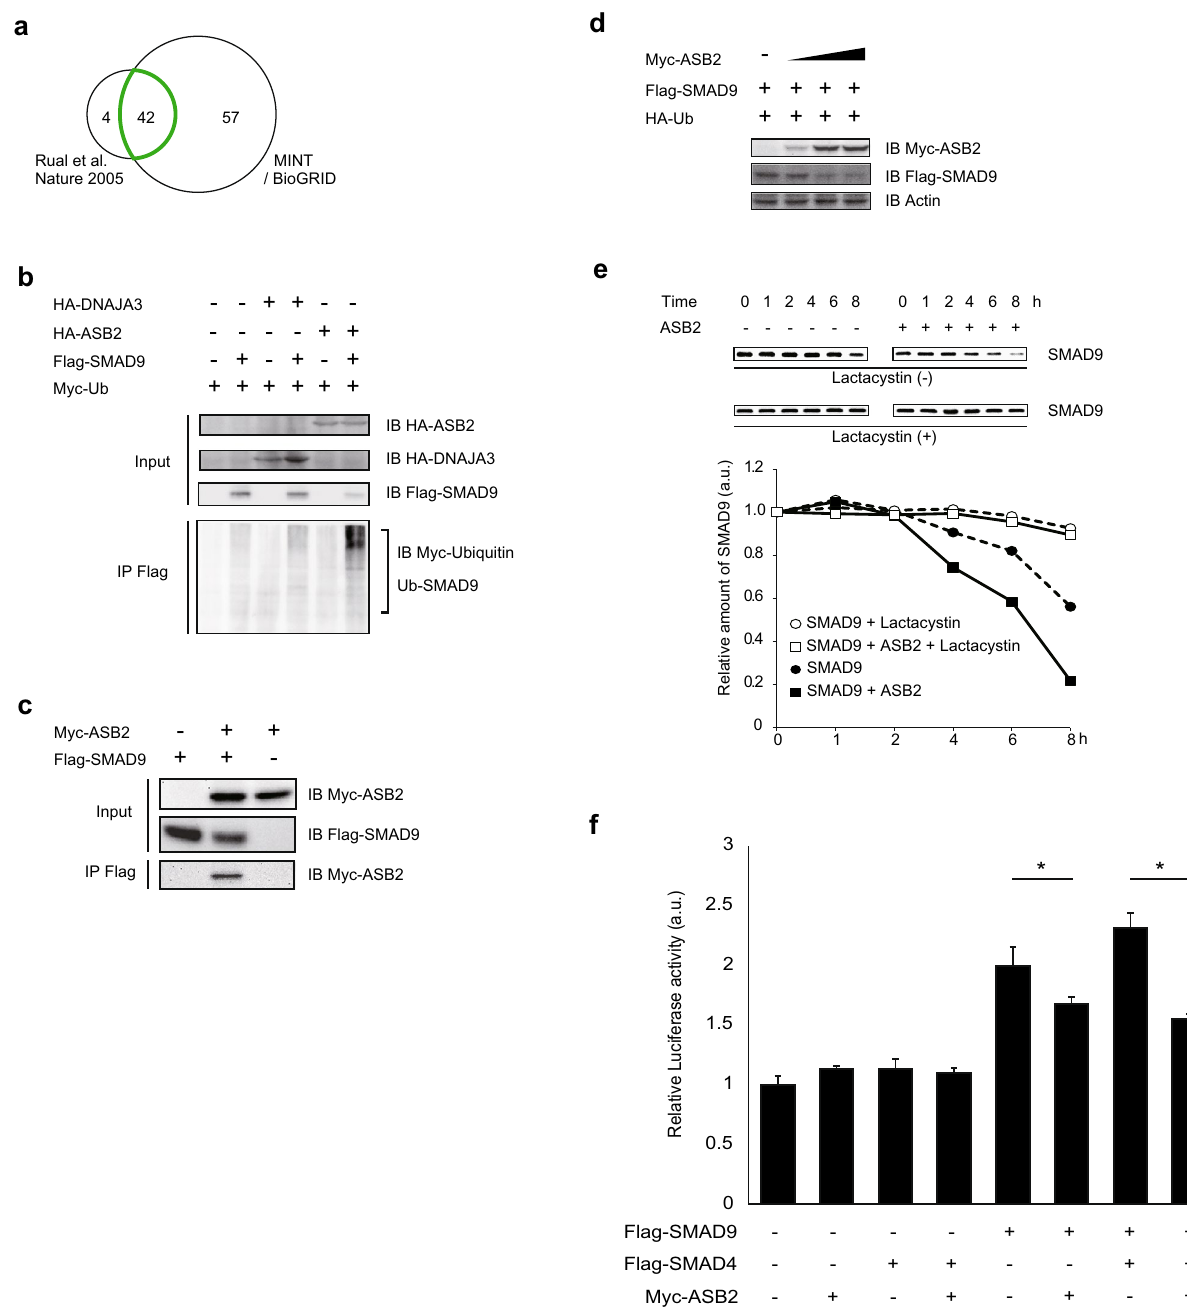
Figure 1. ASB2 is a novel E3 ligase of SMAD9. ( a ) Independent databeses of interactome were used to narrow the candidates for SMAD9-binding proteins. Finally, 42 proteins were remained (see Table1). ( b – d ) HEK293T cells were transfected with vectors encoding indicated tagged proteins and Flag-immunoprecipitates or lysates were separated using SDS-PAGE and immunoblotted with the indicated antibodies. ( b ) ASB2 but not DNAJA3 ubiquitilated SMAD. ( c ) ASB2 interacts SMAD9. ( d ) The amounts of transfected vector encoding Myc-Asb2 were 0, 0.1, 1, and 2 µg, respectively (from the left column) The total amount of the transfected vector was adjusted using empty vector. The protein amount of SMAD9 was negatively correlated with that of ASB2. ( e ) Pulse chase analysis. To terminate further protein synthesis, cells were treated with 50 µg/mL cycloheximide with or without 10 µM lactacystin at 24 h after transfection. Total cell lysates were obtained at the indicated times and subjected to western blot analysis. Protein levels were determined using densitometry. ( f ) Asb2 suppress BMP signalling through degradation of Smad9. HeLa cells were co-transfected with Xvent2-Luc plasmid, which expresses luciferase under BMP signalling, and a pGL4.75 vector as a control, which constantly expresses Renilla luciferase, and vectors encoding Flag-SMAD9, Flag-SMAD4 and Myc-ASB2 as indicated. Cells were treated with 100 µM BMP2. Using cell lysates obtained 24 h after transfection, the luminescence of both firefly and Renilla luciferase were measured. Luciferase activity under BMP signalling was normalized with Renilla luciferase activity. The cropped gel images were delineated and uncropped gel images are shown in the Supplementary Information. The data are shown as the mean ± s.d. Statistical analysis was performed using one-way ANOVA with Tukey’s multiple comparison tests. * p < 0.05; ns, not